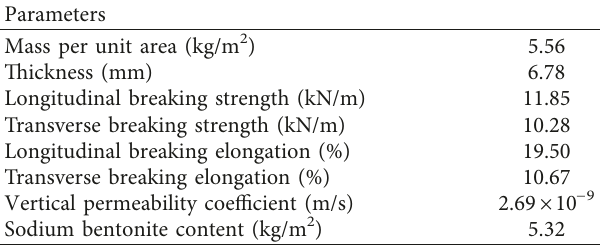
Table 1: Basic performance of GCLs.